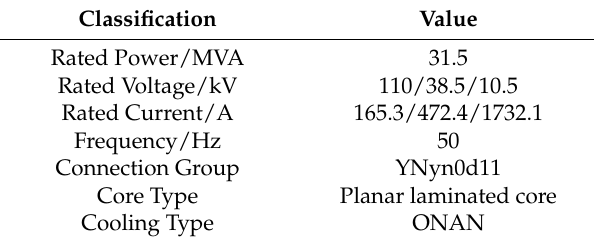
Table 2. Characteristics of 110 kV Oil-immersed three-phase three-limb Transformer.